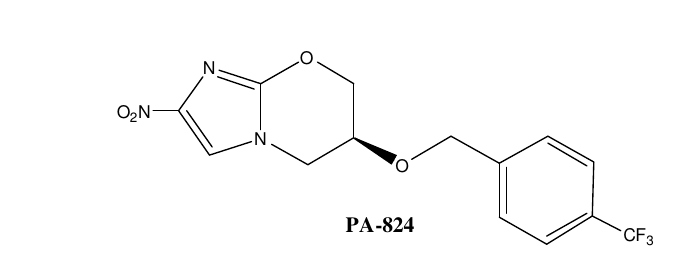
FIGURE 12. Structure of